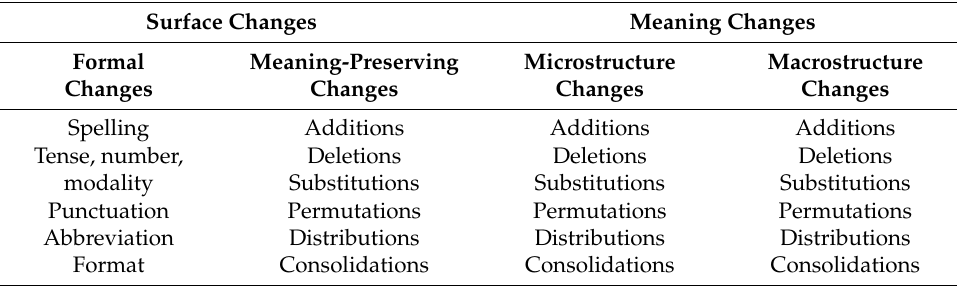
Table 1. Faigley and Witte’s (1984) taxonomy of